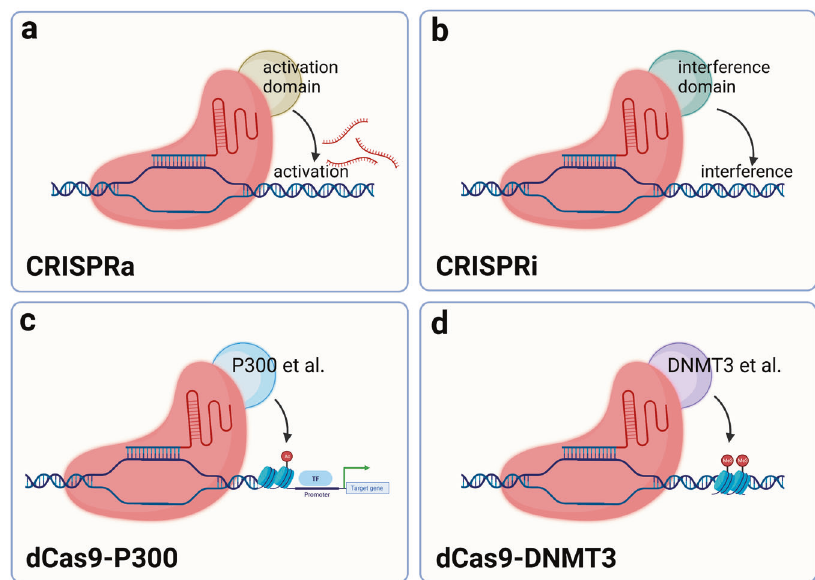
Fig. 3 Schematic diagram of dCas9-based tools to regulate expression. a The dCas9 fusion VP64, VPR and other transcriptional activation effectors bind near the gene transcription start site to promote gene transcription. b dCas9 may be fused with KRAB or other transcriptional repressor effectors and bind to the gene transcription start site to silence gene transcription. c The complex formed by the fusion of dCas9 with P300 or other histone acetylases binds the gene transcription start site or enhancer region and promotes histone acetylation, which in turn enhances gene transcription. d dCas9 fused with DNMT3 and other DNA methyltransferases may bind the gene transcription start site to promote DNA methylation and thereby knock down gene transcription. (Figure was created with